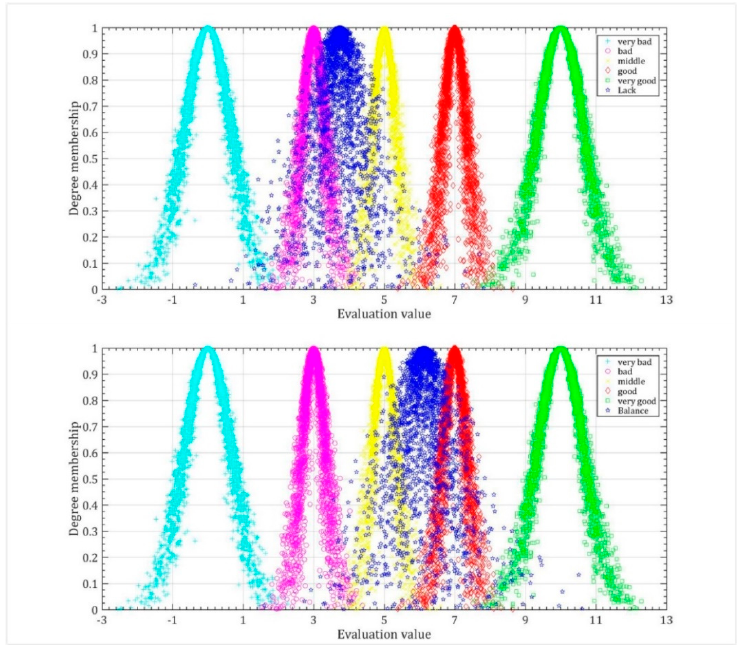
Figure 9. Cloud image of welfare evaluation grades of land-lost farmers' households under different livelihood assets.